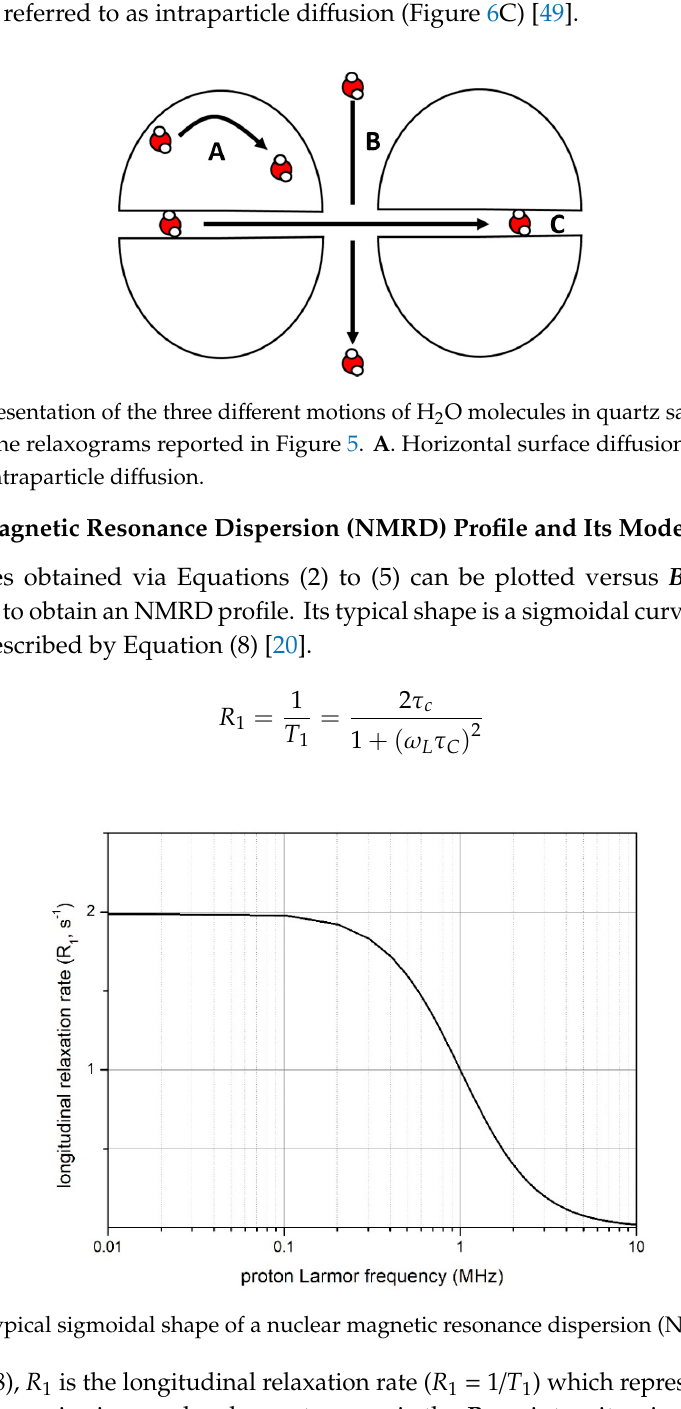
Figure 7. Typical sigmoidal shape of a nuclear magnetic resonance dispersion (NMRD) profile.